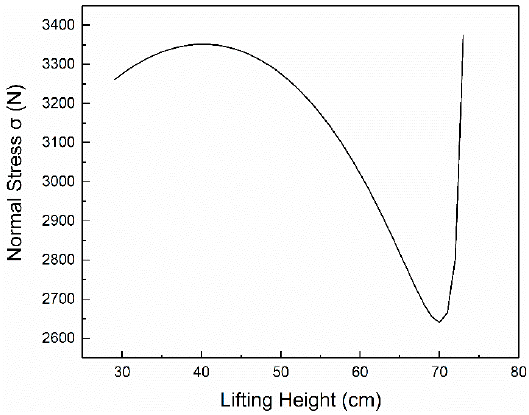
Figure 3. The relationship between F and h .